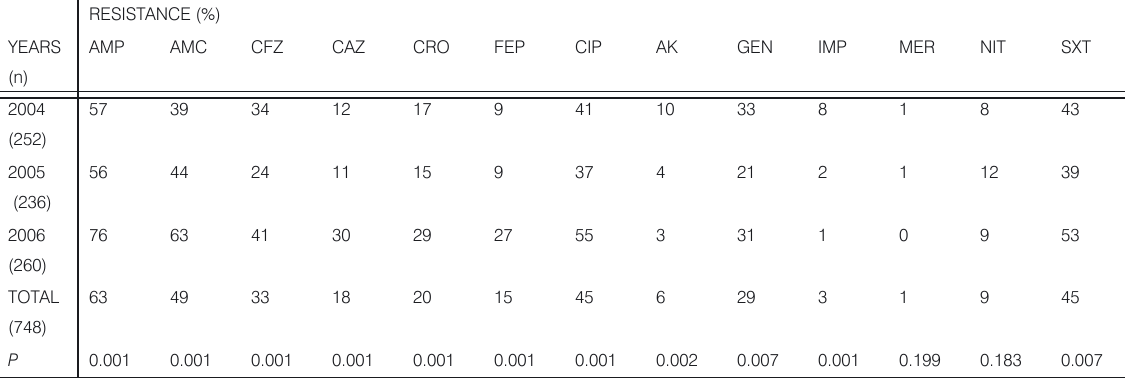
P, p value; n, number of isolates; (AMP),ampicillin; (AMC), amoxicillin-clavulonic acit; (CFZ), cefazolin; (CAZ) , ceftazidime; (CRO), ceftriaxsone; (FEP), cefepim; (CIP),ciprofloxazine; (AK), amikacin; (GEN), gentamicin; (MER), meropenem; (IMP), imipenem; (NIT), nitrofurantoin,